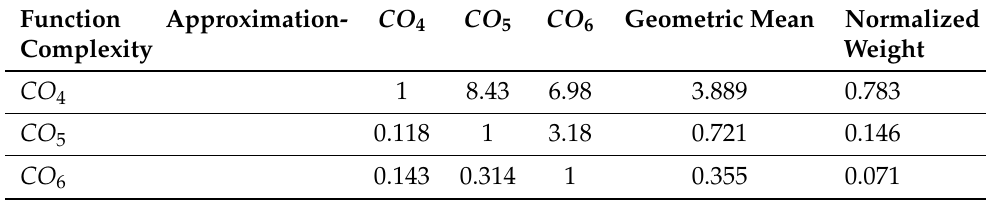
Table 15. Comparison between suitable components for function approximation with respect to complexity.